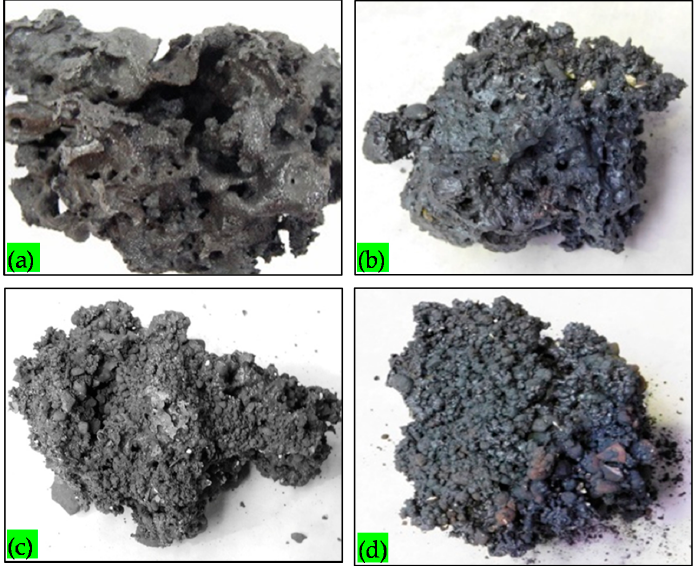
Figure 1. Macrostructure of agglomerate produced using coke + lignin. ( a ) Coke; ( b ) coke + 20% lignin; ( c ) coke + 50% lignin; ( d ) coke + 86% lignin.